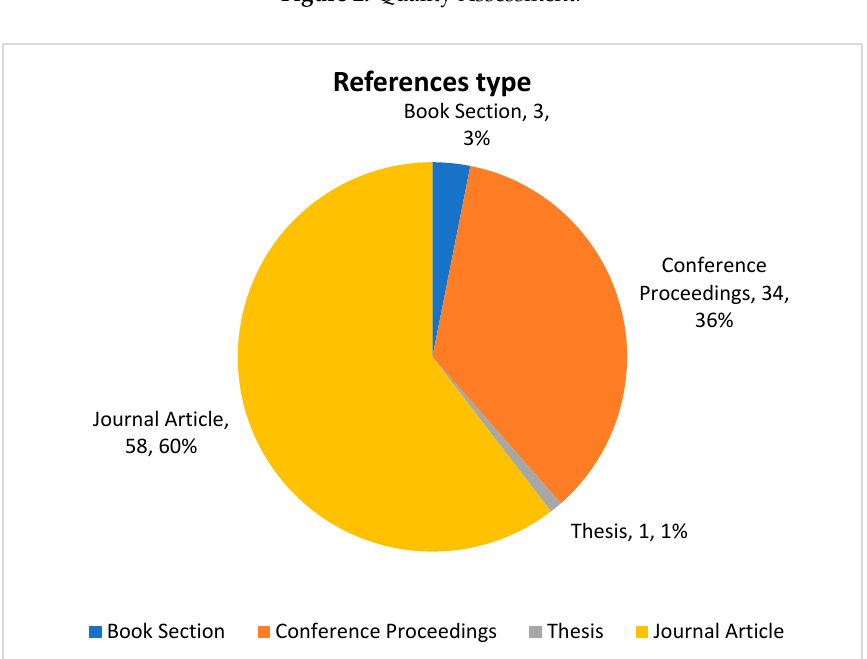
Figure 3. Type of references.